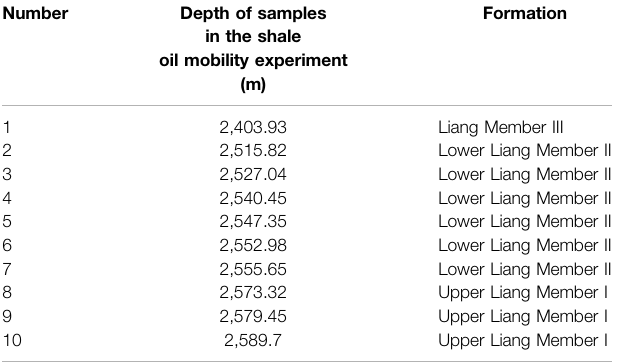
TABLE2| Thedepthandmembersofsamplesintheshaleoilmobilityexperiment. Number Depth of samples in the shale